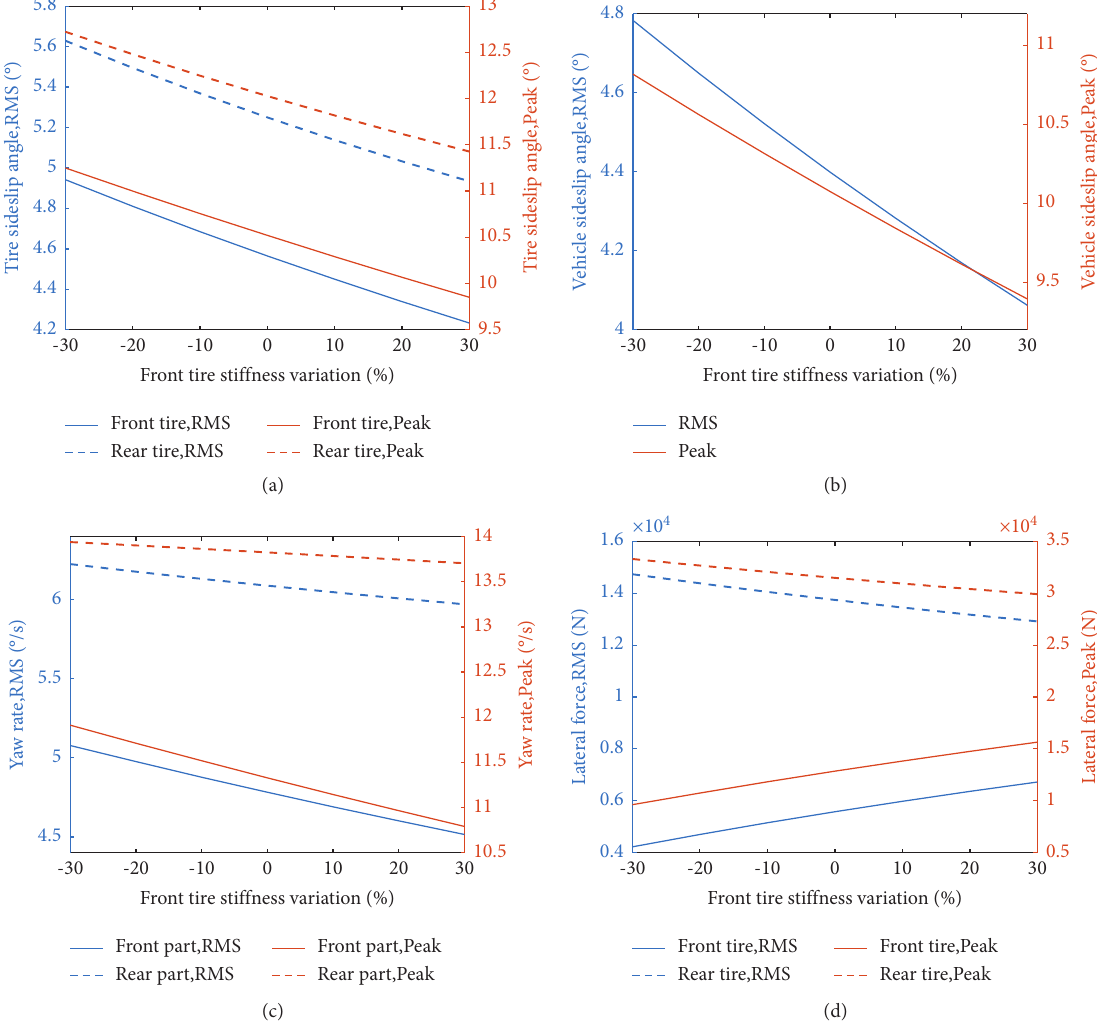
Figure 6: Vehicle performance of the front tire cornering stiffness variation. (a) RMS and peak value of tire sideslip angle. (b) RMS and peak value of vehicle sideslip angle. (c) RMS and peak vehicle yaw rate. (d) RMS and peak value of lateral